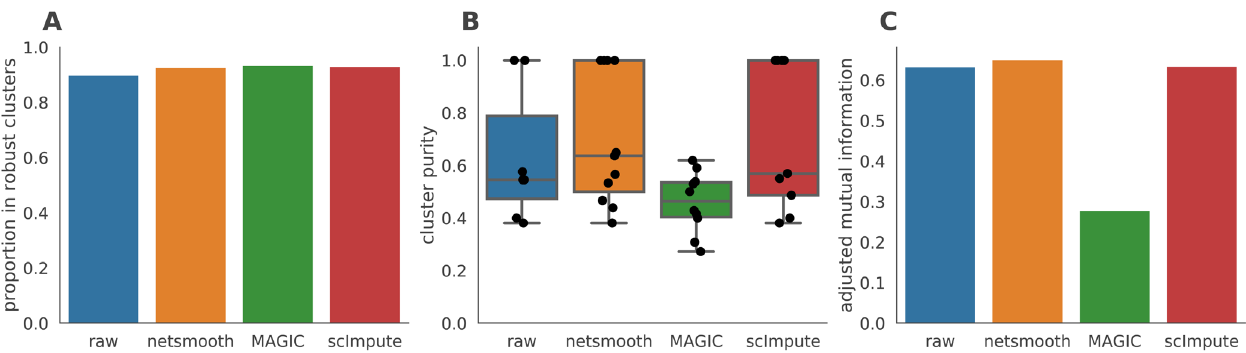
Figure 5. The Embryonic development dataset. A ) The proportion of cells which were assigned to robust clusters. All three methods lead to better clusterability, with MAGIC having the strongest effect. B ) cluster purity (proportion of dominant cell type) for the robust clusters. netSmooth produces the most pure clusters in terms of cell types. C ) Adjusted mutual information of clusterings and cell types. Only netSmooth increases the AMI over the non-preprocessed data. The online version of this figure is interactive.